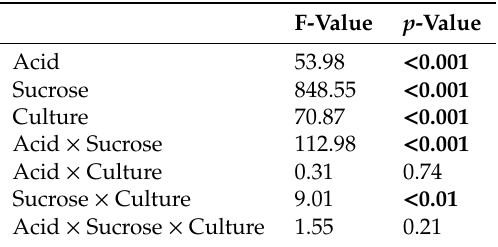
Table 4. F- and p -values for mixed model Analysis of Variance for Sweetness Intensity Ratings. Significant effects ( p ≤ 0.05) are marked in bold.